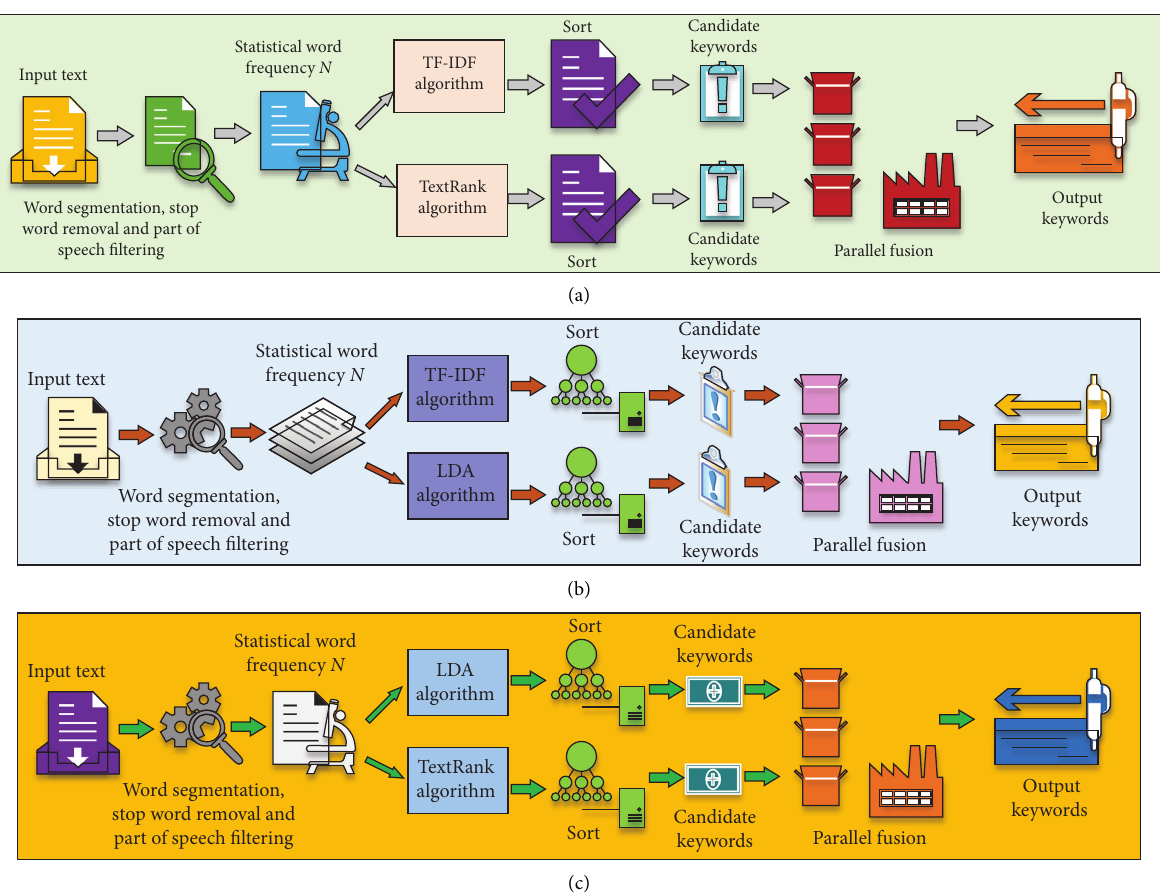
Figure 7: Design of three kinds of parallel fusion network news keyword extraction scheme. (a) Scheme 1 flow chart. (b) Scheme 2 flow chart. (c) Scheme 3 flow